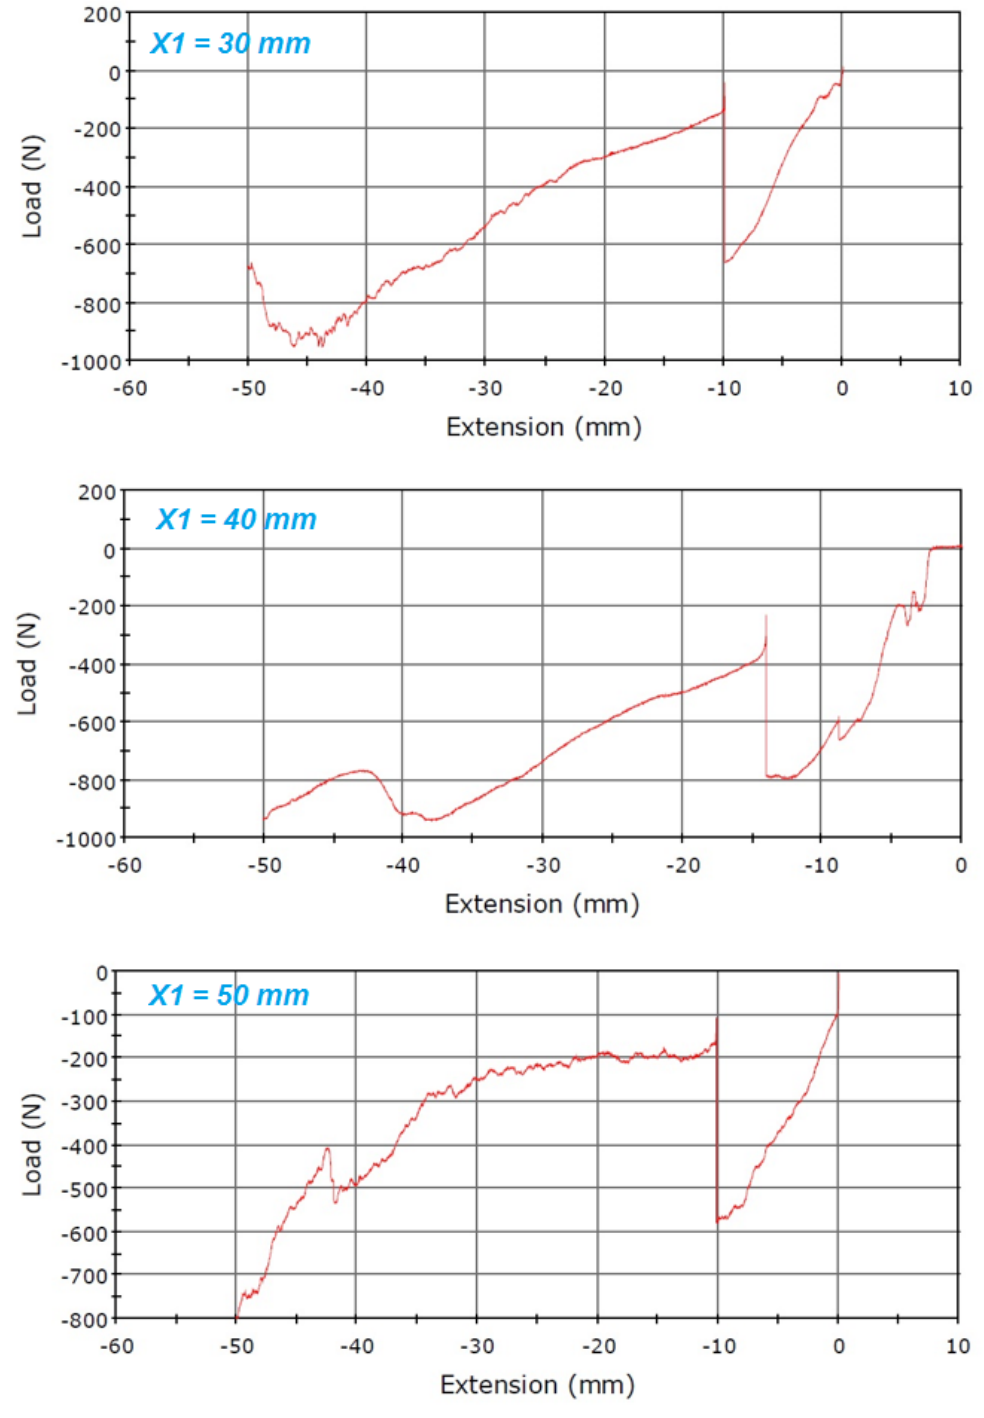
Figure 12. Variation of force relative to the displacement.